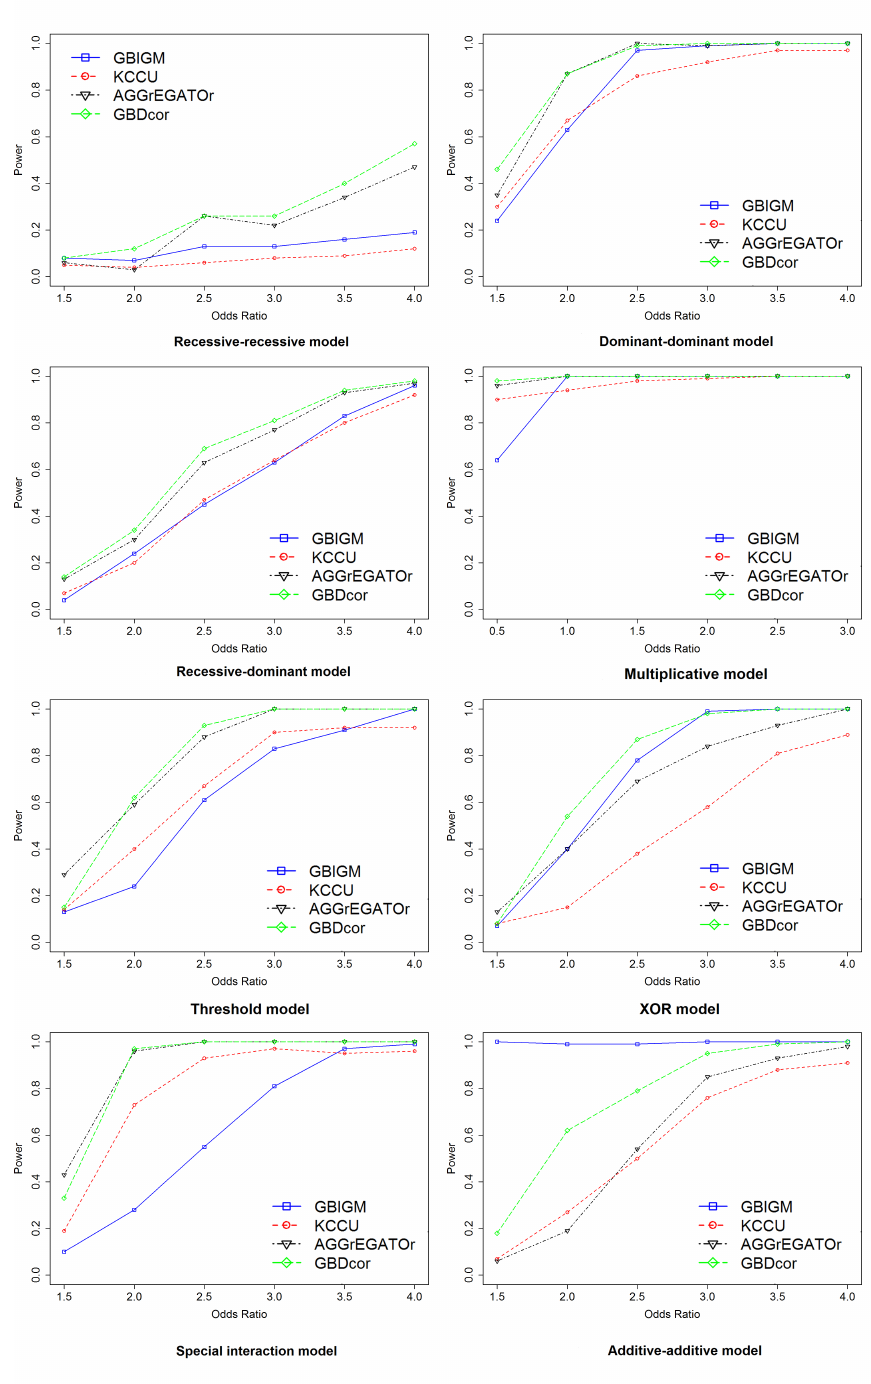
Figure 2. Empirical, simulation-based statistical power of GBIGM, KCCU, AGGrEGATOr, and GBDcor under eight disease models, after varying the OR ∈ { 1.5,2,2.5,3,3.5,4 }